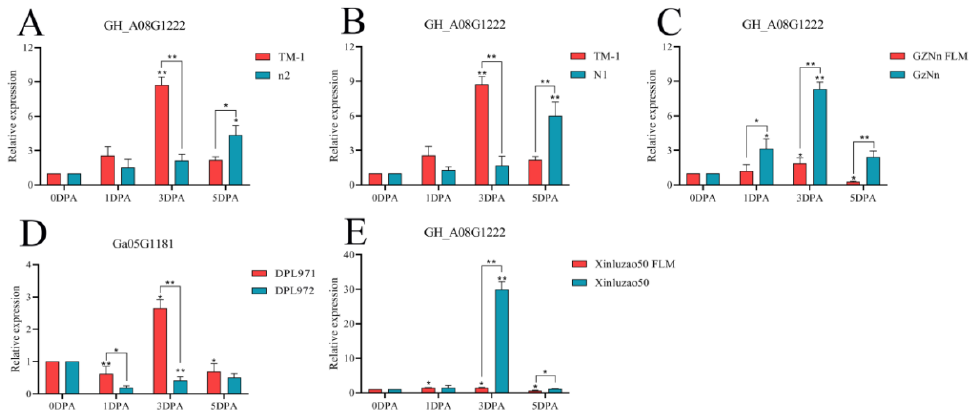
Figure 17. Relative expression levels of the GH_A08G1222 gene in upland cotton. ( A – C , E ) Upland cotton; ( D ) homologous gene of Asian cotton. Asterisks at top of bars indicate statistically significant differences between periods (* p < 0.05, ** p < 0.01).